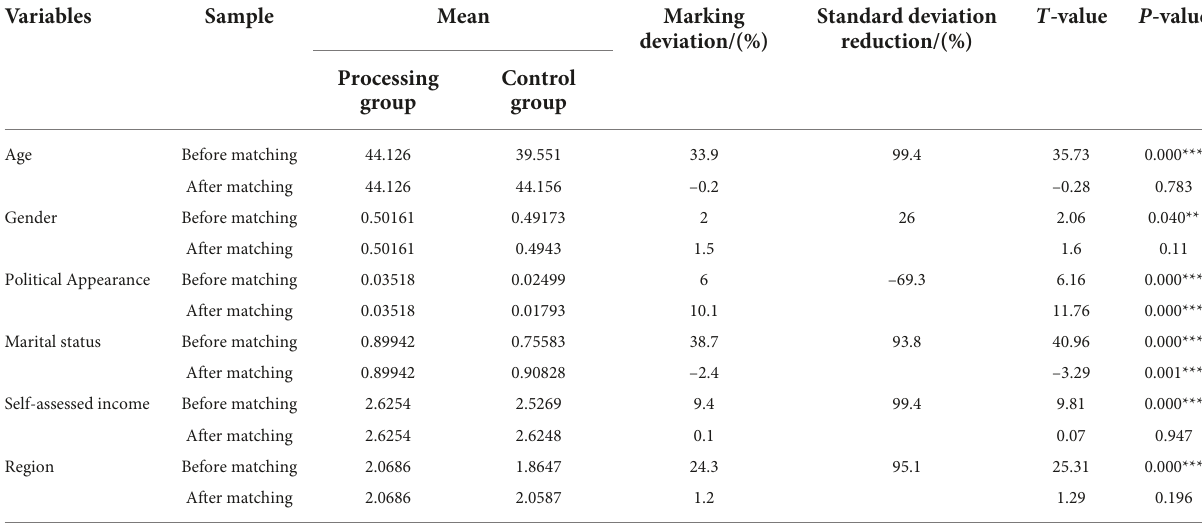
TABLE 4 Matching balance test